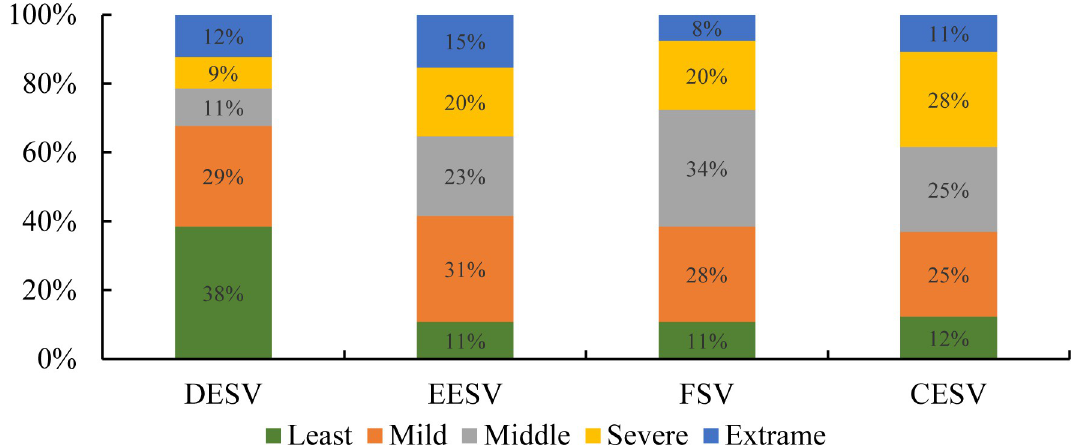
Fig 5. Hierarchical statistics of the vulnerability of the BRI